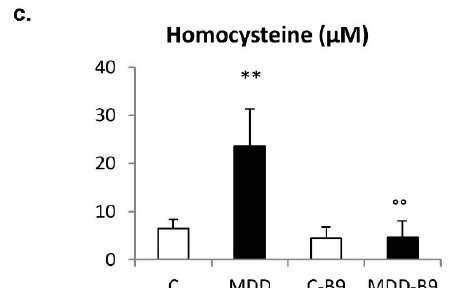
Figure 1. Effects of the maternal dietary regimen on plasma concentrations of folate ( a ), vitamin B12 ( b ) and homocysteine ( c ) in 21-day-old rat pups. Data are mean ± SD and were obtained from 14 ≤ n ≤39 individuals. Statistically significant differences: ** p < 0.01: With respective control; °° p < 0.01: Between MDD and MDD + B9. C = control diet; MDD = methyl donor deficient diet.